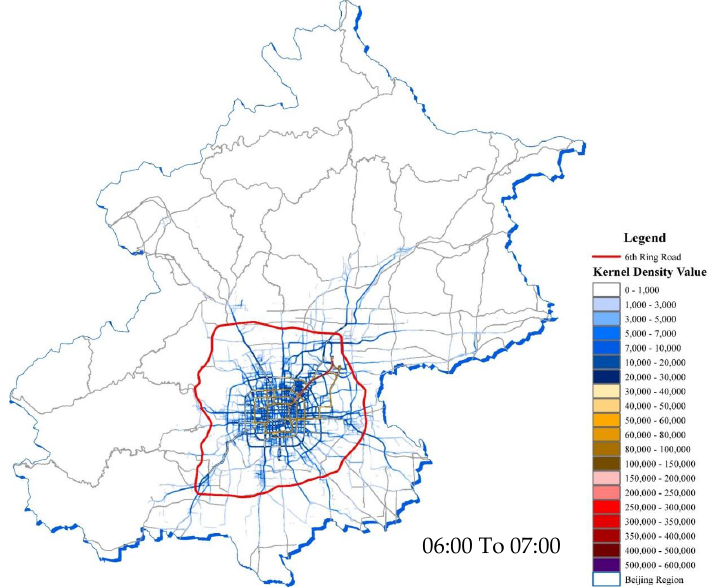
Figure 13. Kernel density analysis results.